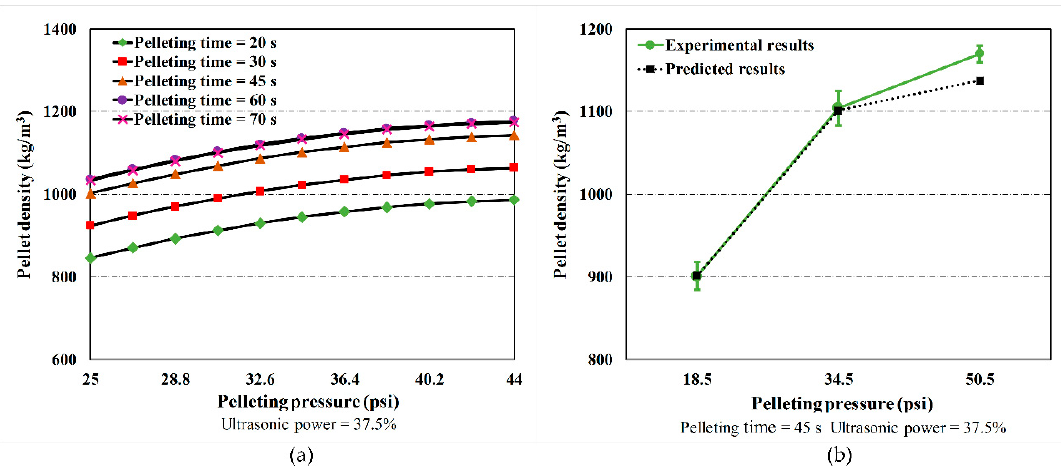
Figure 4. The effects of pelleting pressure on the pellet density. ( a ) The predicted pellet density in relation to pelleting pressure at different levels of pelleting time (ranging from 20 s to 70 s) when the ultrasonic power was set to 37.5% and the pelleting pressure increased from 25 psi to 44 psi. ( b ) For pellet density, the comparison between the model results and experimental results at various levels of pelleting pressure (mean value ± SD).